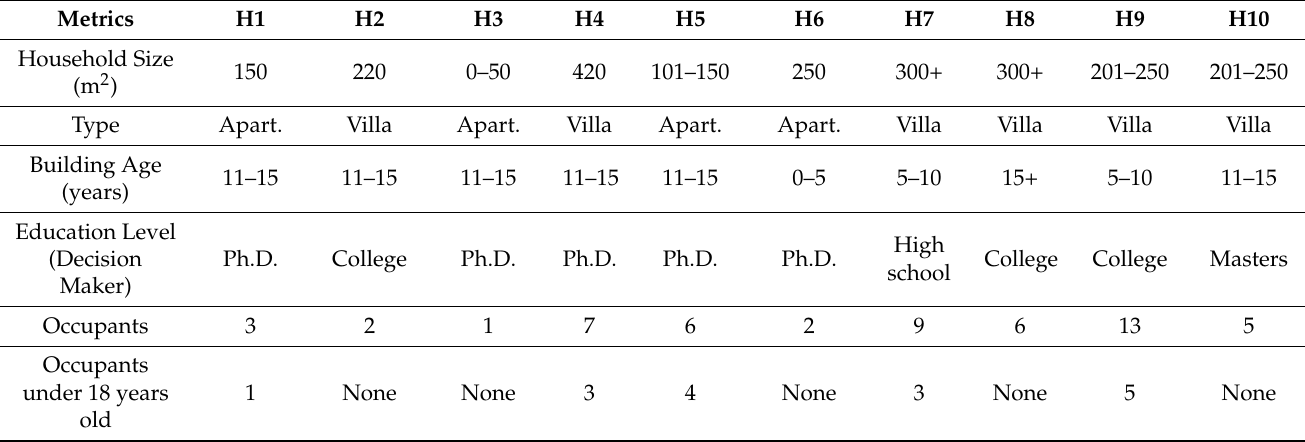
Table 1. Socioeconomic details of the electricity profiling study participants (H: